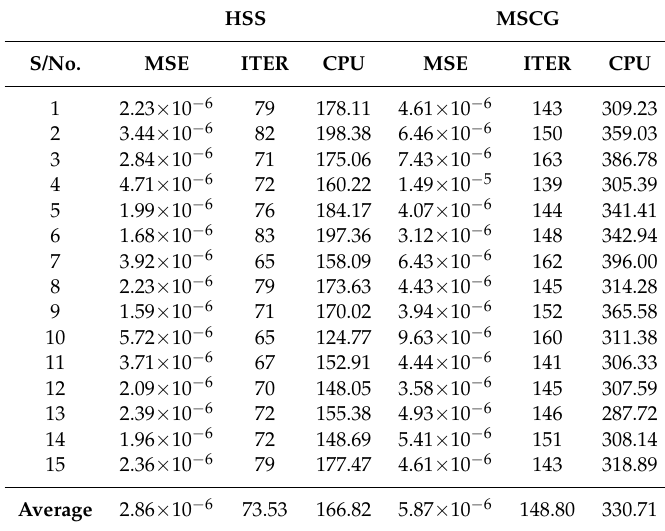
Table 12. Numerical results of HSS and modified self-adaptive conjugate gradient (MSCG) methods with the initial points randomly